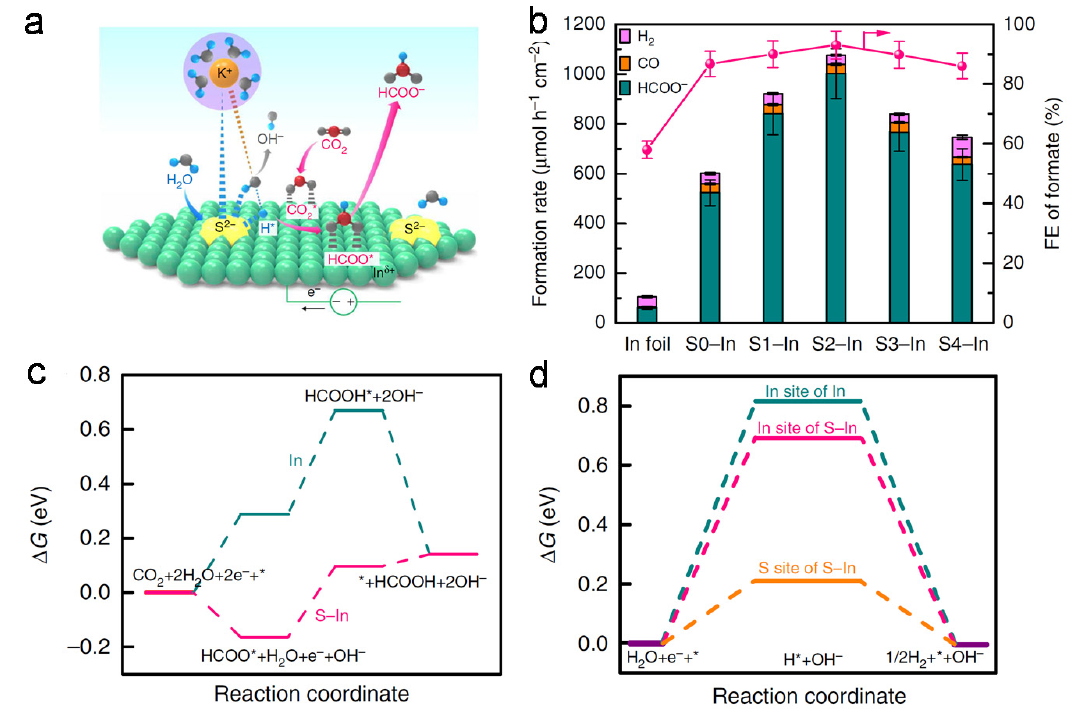
Figure 8. ( a ) Schematic illustration for the role of S 2 − in promoting water dissociation and *H formation for the reduction of CO 2 to formate. ( b ) Formation rates of H 2 , CO, and HCOO − and FE HCOOH for In foil and S–In catalysts at − 0.98 V vs. RHE. Density functional theory (DFT) calculation results for: ( c ) Gibbs free energy diagram for CO 2 RRs to HCOOH on In(101) and S–In(101) surfaces; ( d ) Gibbs free energies for the formation of H* on pure In(101) and on the In and S sites of S–In(101) surfaces. The free energies of ( c ) and ( d ) are shown relative to gaseous CO 2 and H 2 [73]. Copyright 2019, Nature.